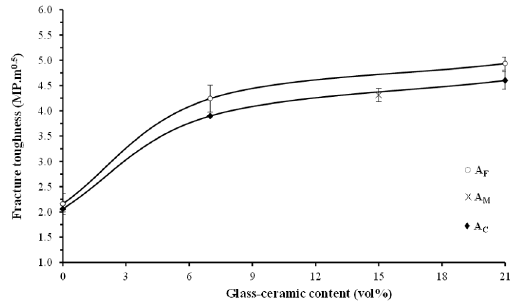
Figure 3. Fracture toughness in function of the LZSA content of the alumina ceramics and LZSA/alumina composites.